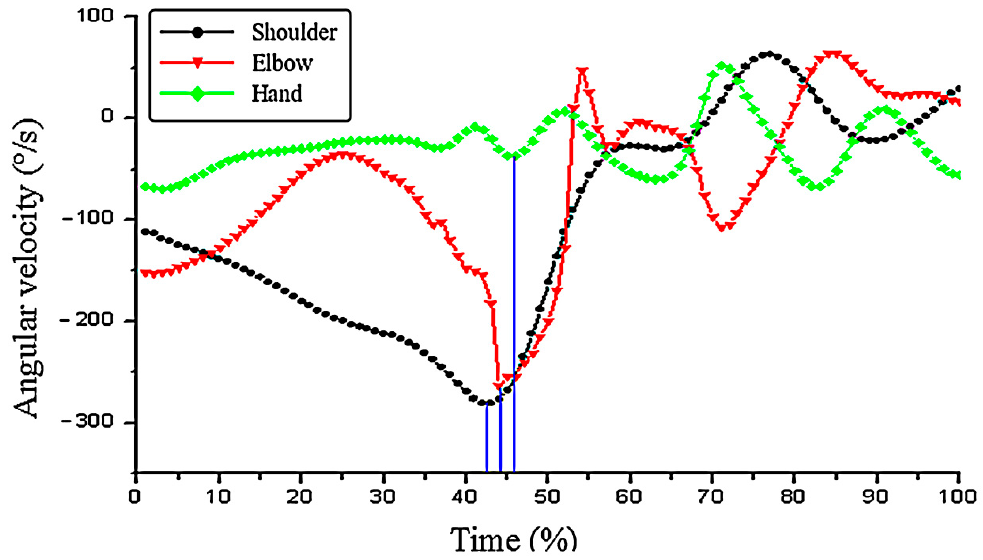
Figure 7. Angular velocity change in the shoulder–elbow–hand joints in the beginner group.